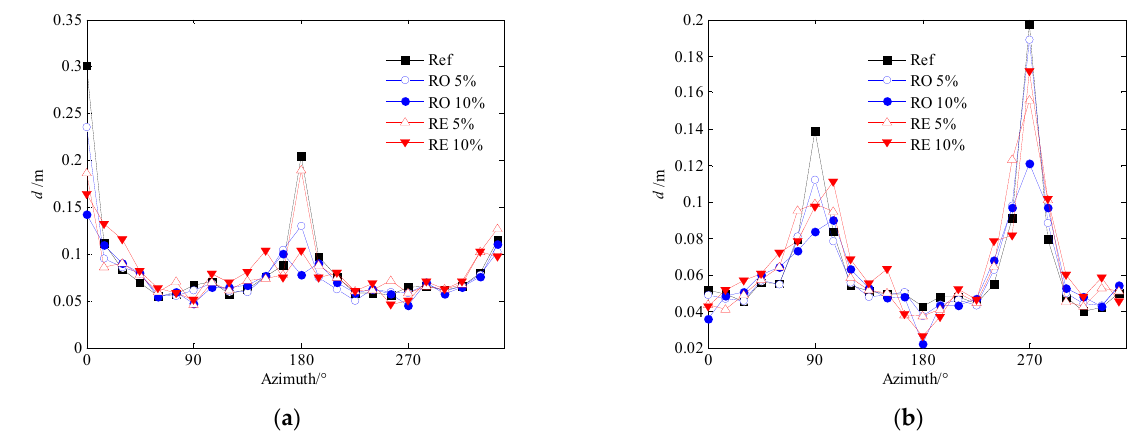
Figure 7. Standard deviations of displacements in different azimuths: ( a ) x -direction. ( b ) y -direction.